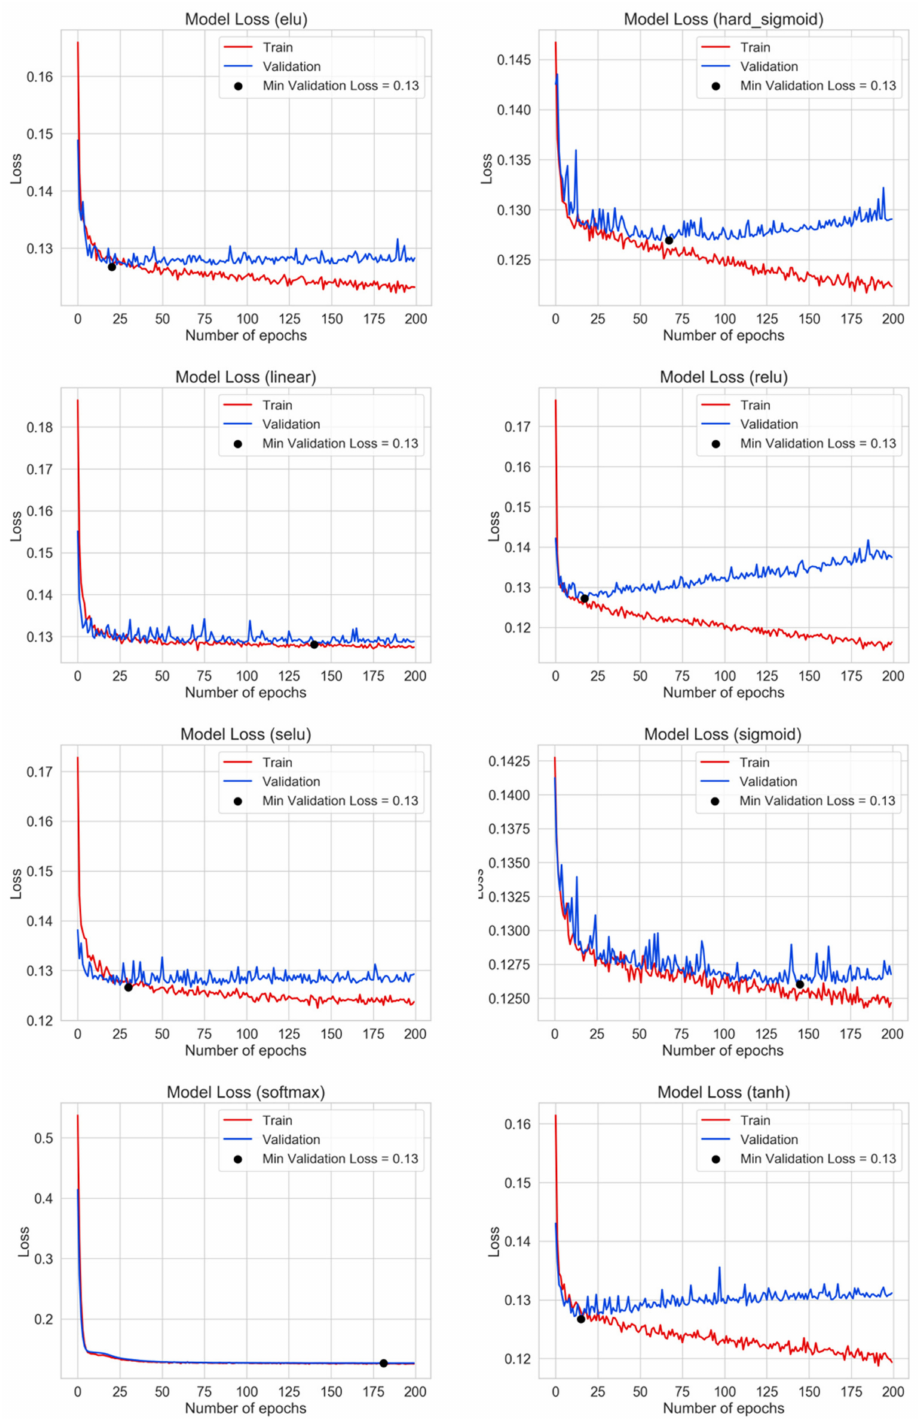
Figure 4. Comparison of model loss according to activation